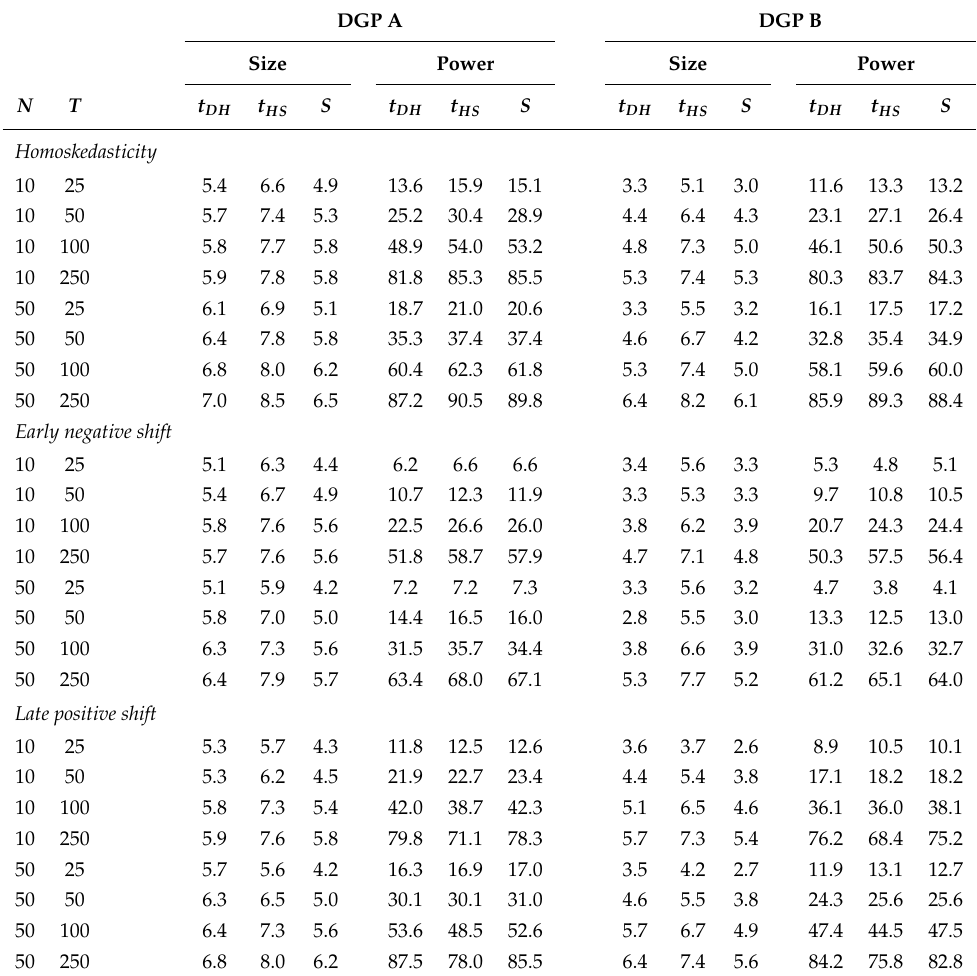
Table A3. Rejection frequencies in cross-dependent panels—equicorrelation. γ i ∼ iid U ( 0.9,1 ) , µ i ∼ iid U ( 0,0.02 ) , ω = 0.5. DGP B: θ i ∼ iid U ( 0.2,0.4 ) . Power is computed using size-adjusted 5% critical values; 25,000 replications were